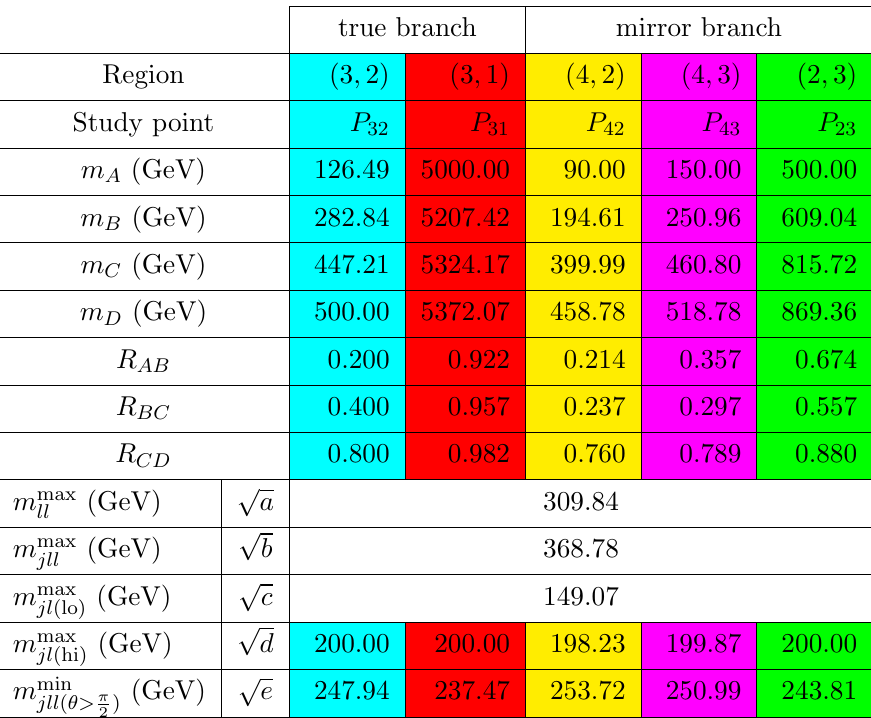
Table 2 . The same as table 1, except now the starting point is a point ( P